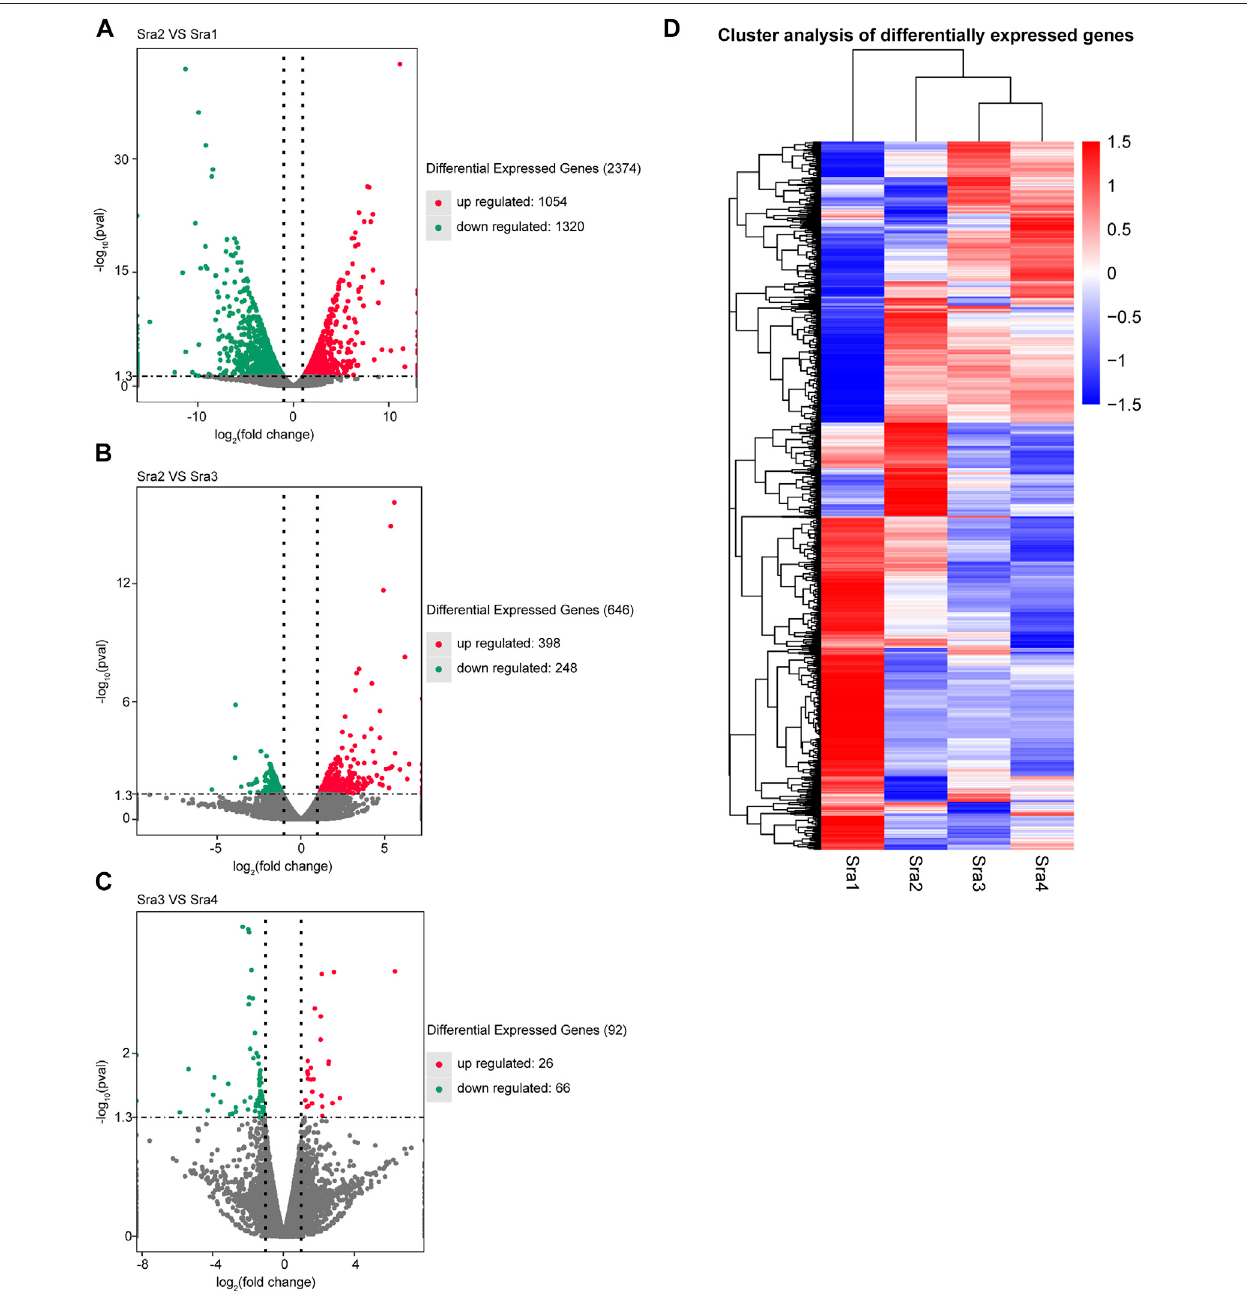
FIGURE 1 | Screening of DEGs. (A – C) Volcano map of DEGs in each PCG, (A) Sra1 vs. Sra2 PCG; (B) Sra2 vs. Sra3 PCG; and (C) Sra3 vs. Sra4 PCG. The horizontal axis represents the variation of gene expression multiple in different samples, and the vertical axis represents the statistical signi fi cance of the variation of the gene expression level. Genes with a signi fi cant differential expression were represented by red dots (up-regulated) and green dots (down-regulated). Genes with insigni fi cant differential expressions were represented by gray dots. (D) DEG clustering diagram of the 4 groups of samples.